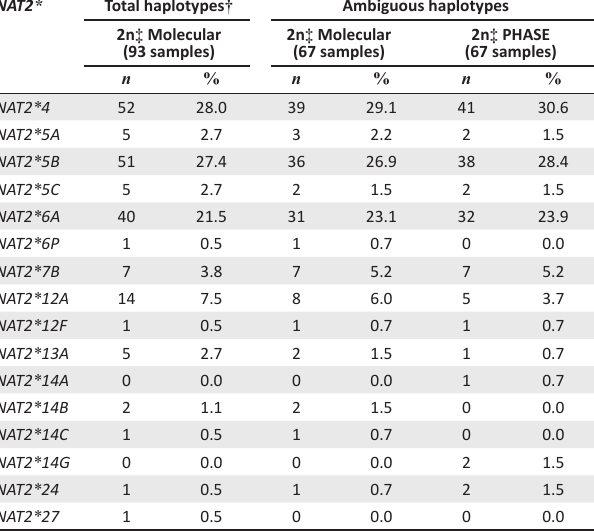
TABLE 2: Haplotype frequencies as derived by molecular methods, as well as predicted by the PHASE computational algorithm, Western Cape, South Africa,